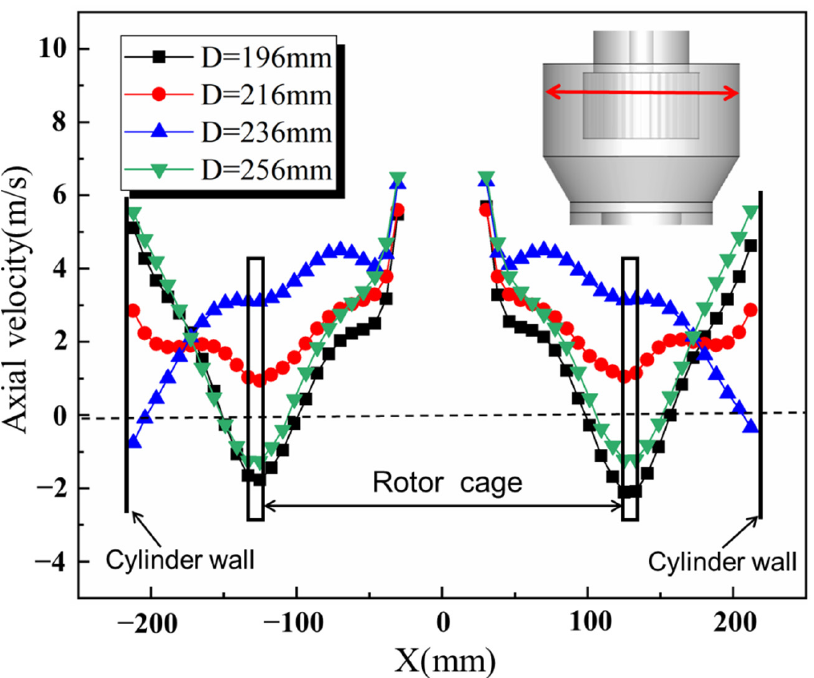
Figure 12. Effect of the guide cone diameter on the axial velocity (Z = − 37.5).